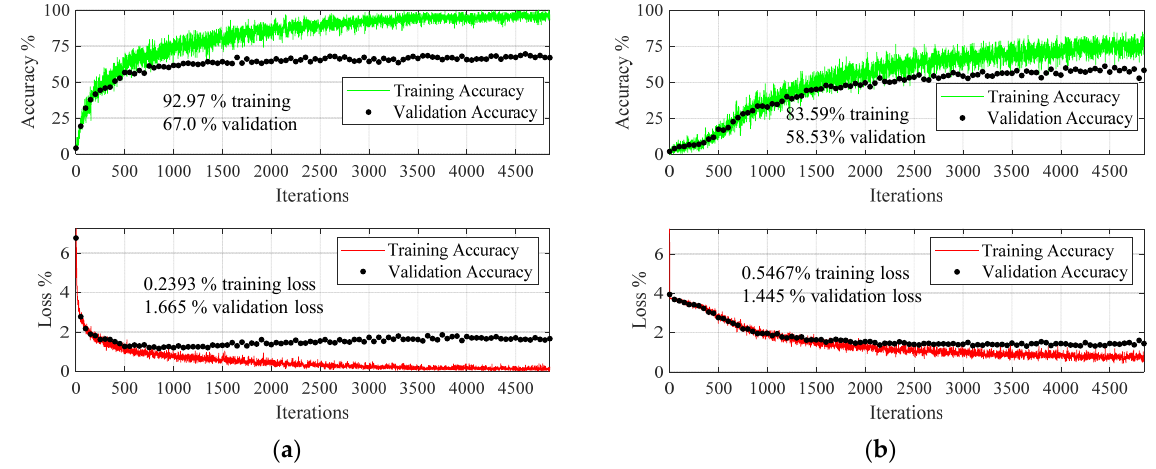
Figure 9. Training and validation results of transfer learning on original data using: ( a ) ResNet18; ( b ) SqueezeNet. (Solid line shows training, dot refers to validation).